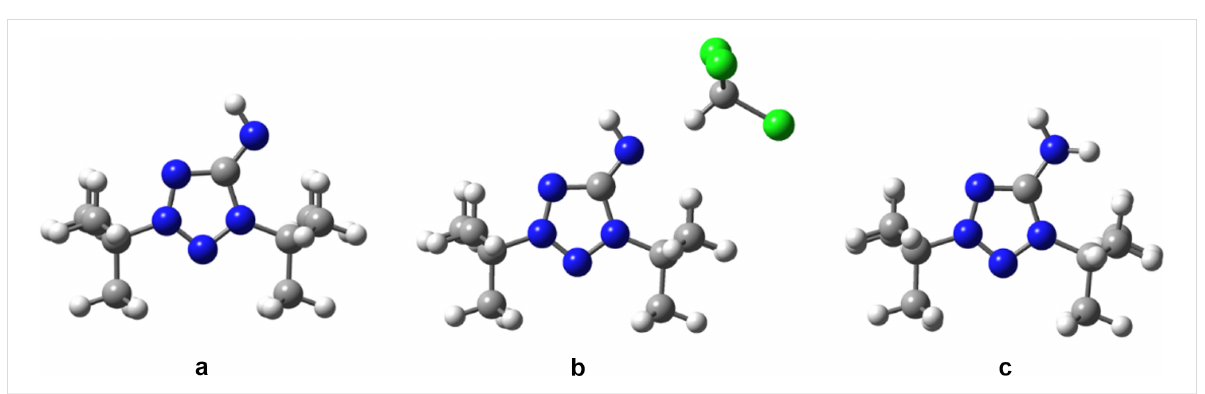
Figure 4: Model structures of 8a used for the calculations of the UV–vis spectra: a) In n -hexane and THF, b) in chloroform, and c) in methanol and